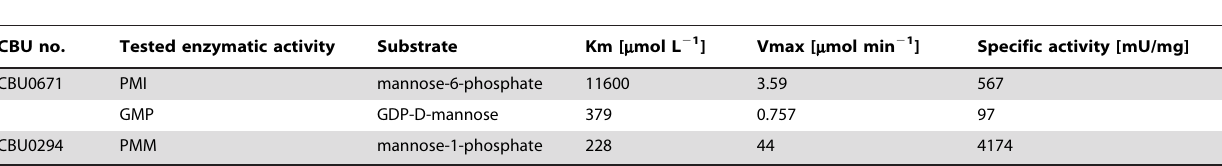
Table 2. Kinetic parameters for C. burnetii CBU0671 and CBU0294.